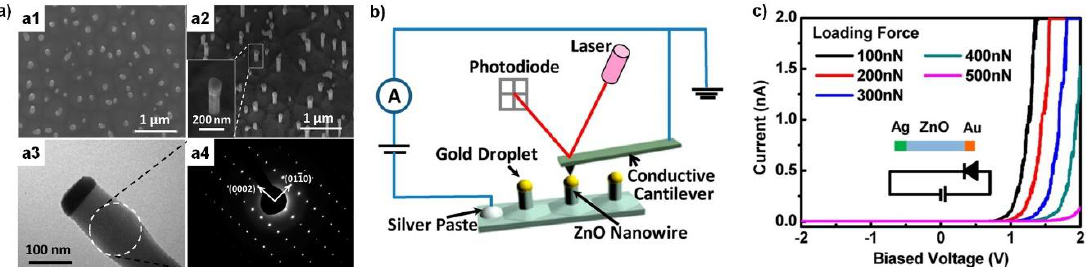
Figure 4. ( a – c ) ZnO vertical nanowires and investigation of their strain response. ( a ) Morphology and structural analysis of the vertically grown ZnO nanowires. ( a 1, a 2) Tilted-view SEM images, along with ( a 3, a 4) typical TEM image and corresponding selected area electron diffraction (SAED) image of the ZnO nanowire with gold tip. ( b ) Illustration of the measurement setup. ( c ) I-V characteristics of the device under different downward forces. ( a – c ) Reproduced from [32] with permission from the